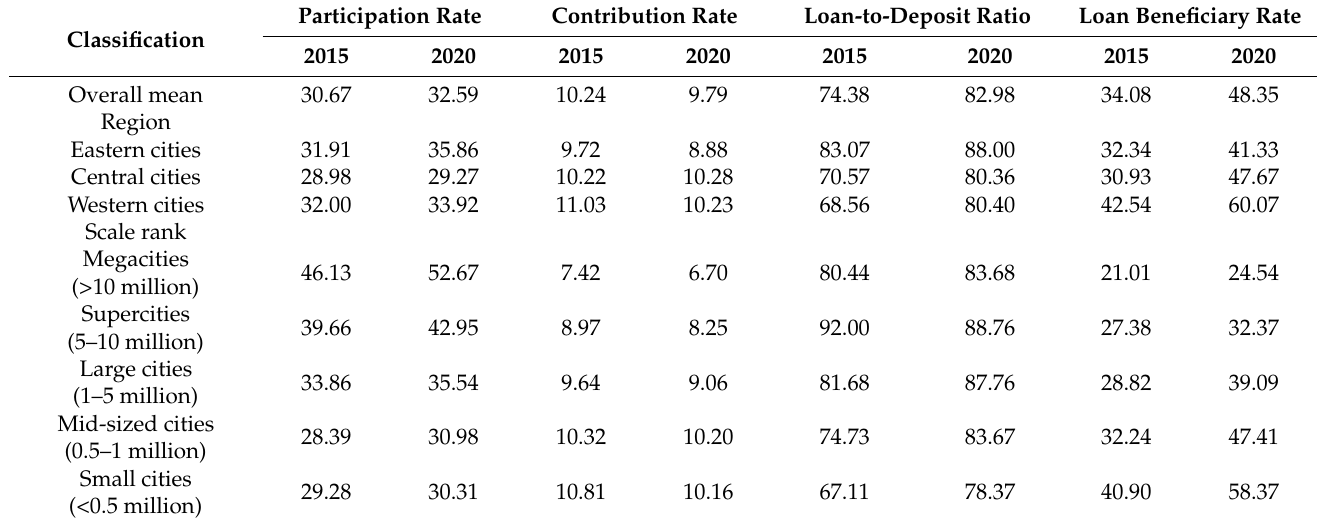
Table 3. The HPF performance of different cities in 2015, 2018 and 2020